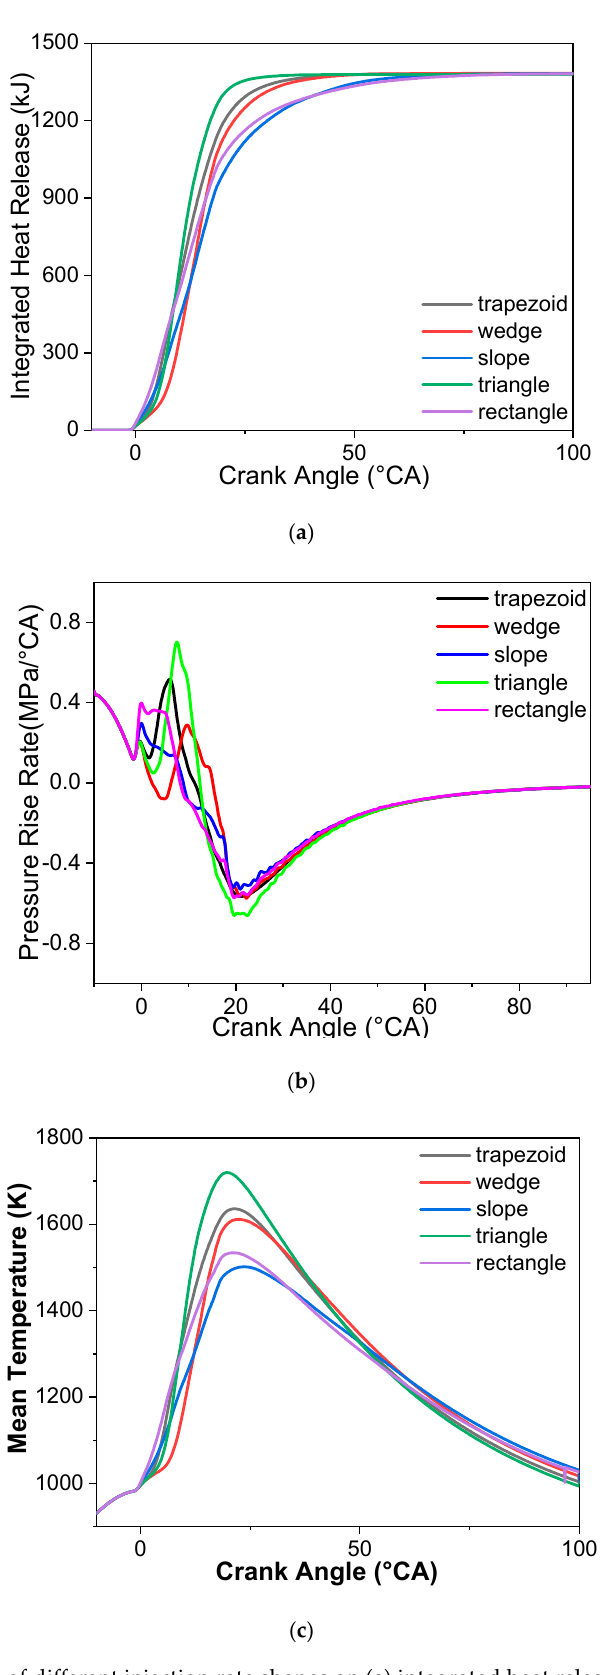
Figure 5. The effects of different injection rate shapes on ( a ) integrated heat release, ( b ) pressure rise rate, ( c ) and in-cylinder mean temperature.